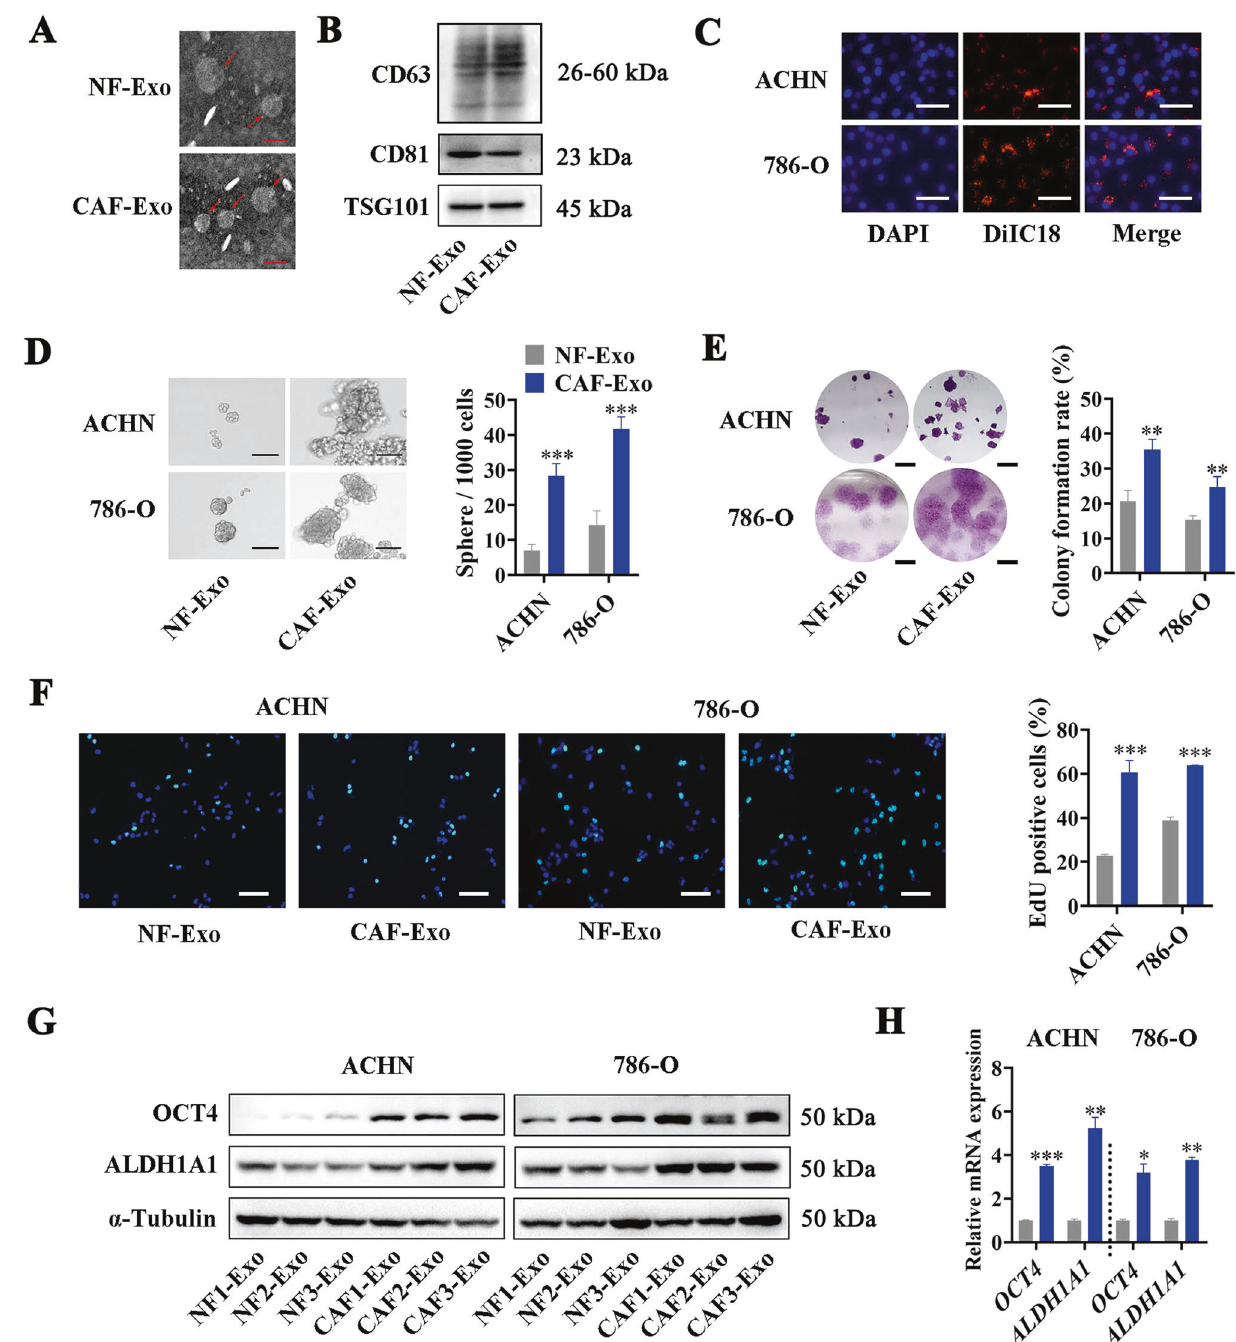
Fig. 3 CAF-derived exosomes promote the cancer stemness of RCC cells. A Representative images of transmission electron micrograph of NFs-secreted exosomes (NF-Exo) and CAFs-secreted exosomes (CAF-Exo), scale bar = 100 nm. B Western blot analysis of exosome markers CD63, CD81, and TSG101 in NF-Exo and CAF-Exo. C Transfer of exosomes from CAFs to RCC cells examined by confocal microscope, scale bar = 50 µm. D Representative images (Left) and histogram statistics (Right) from sphere formation assay of NF-Exo or CAF-Exo treated RCC cells, scale bar = 100 µm. E Representative images (Left) and histogram statistics (Right) from colony formation assay of NF-Exo or CAF-Exo treated RCC cells, scale bar = 0.5 cm. F Representative images (Left) and histogram statistics (Right) from EdU assay of NF-Exo or CAF-Exo treated RCC cells, scale bar = 50 µm. G Western Blot analysis of OCT4 and ALDH1A1 expression in NF-Exo or CAF-Exo treated RCC cells, normalized to α -Tubulin. H RT-qPCR analysis of OCT4 and ALDH1A1 expression in NF-Exo or CAF-Exo treated RCC cells, normalized to β -actin . Cell experiment was repeated three times independently, P value between two groups was obtained by Unpaired t test. * P < 0.05; ** P < 0.01; *** P < 0.001.